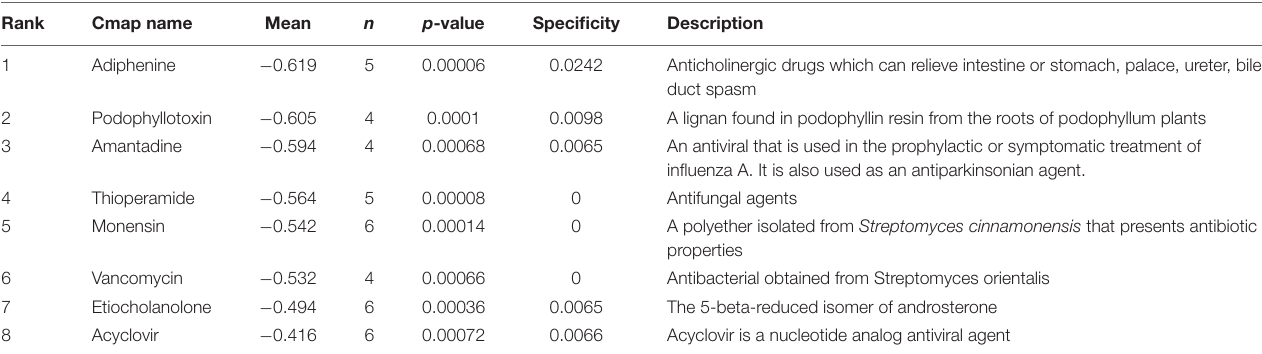
FIGURE 10 | The functional enrichment of ACE2 correlated genes clusters. (A) Cluster 1. (B) Cluster 2. (C) Cluster 3. (D) Cluster 4. The numbers represent “percentage of genes.” TABLE 1 | Top small molecules based on DEGs of COVID-19 patients